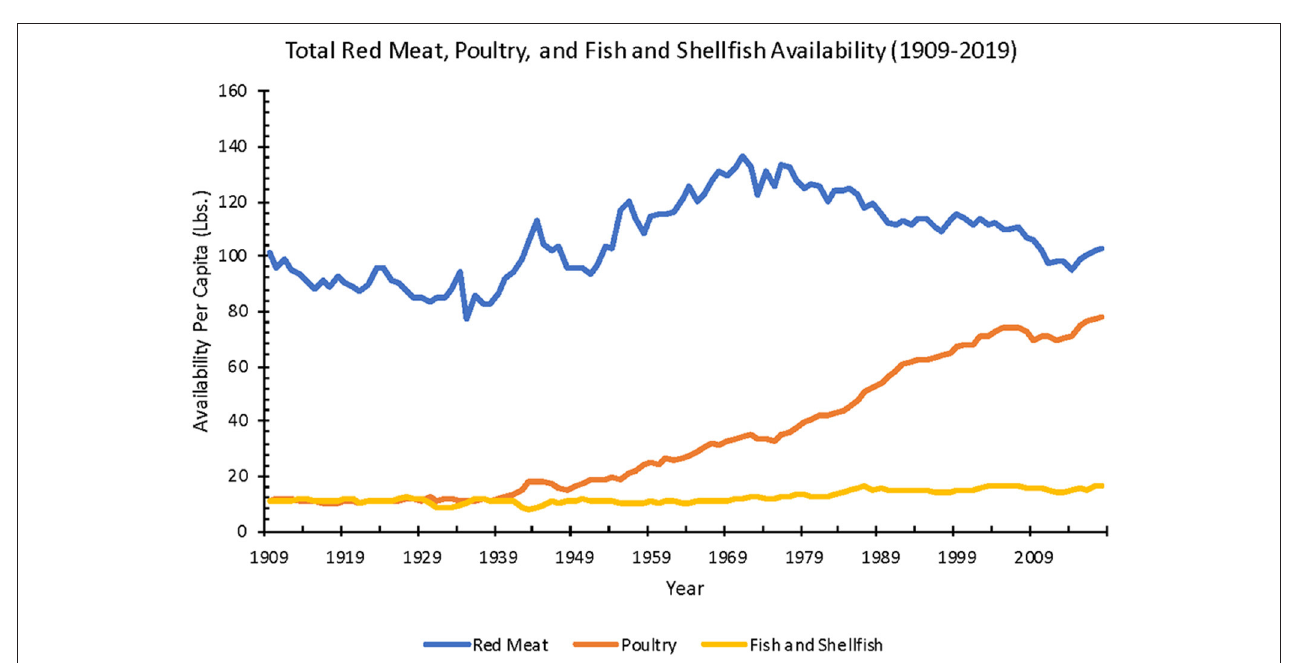
Frontiers in Nutrition |